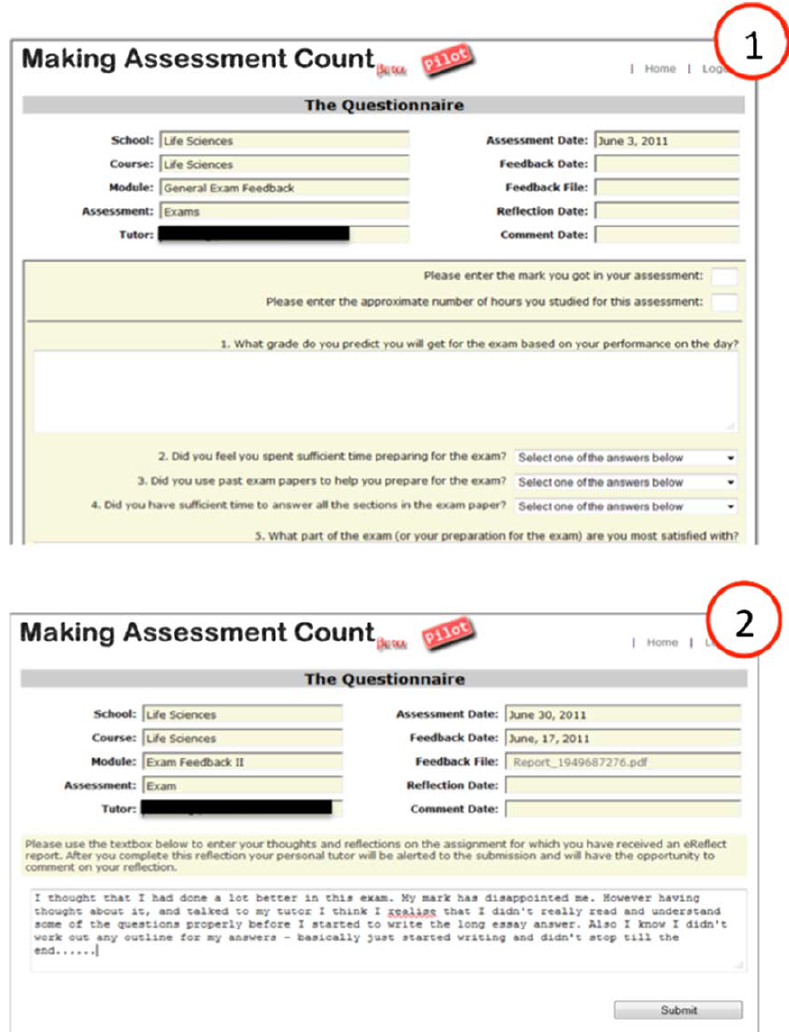
Figure 2. Screenshots of the MAC tool. (1) The customisable online questionnaire students are asked to complete and (2) the area where they enter their reflective